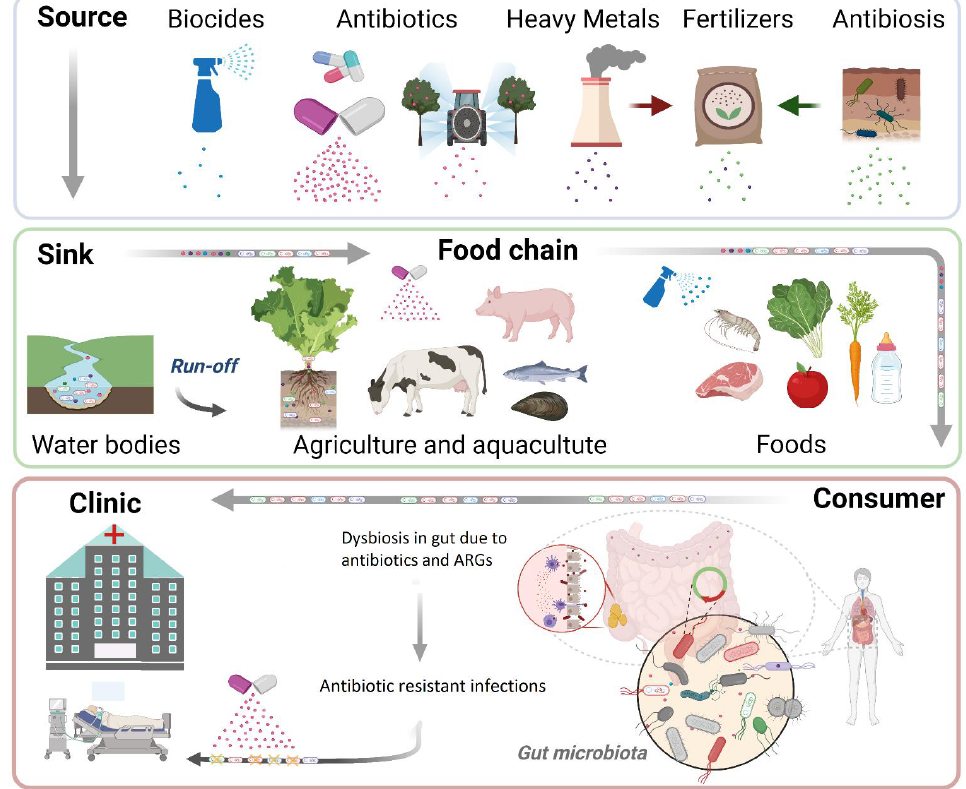
Figure 1. The selective flow of ARGs from the environment to clinic. Clinical, agricultural, and natural antibiotics as well as biocides and heavy metals select for ARGs and contaminate plant, animal, and fish products. Contaminated foods end up into the gastrointestinal tract of humans, where antibiotic resistance emerges from antibiotic presence or is transferred from ARGs to gut microbiota. The endpoints of this antibiotic resistance transmission are human pathogens, which de- velop AR infections. Created with BioRender.com.